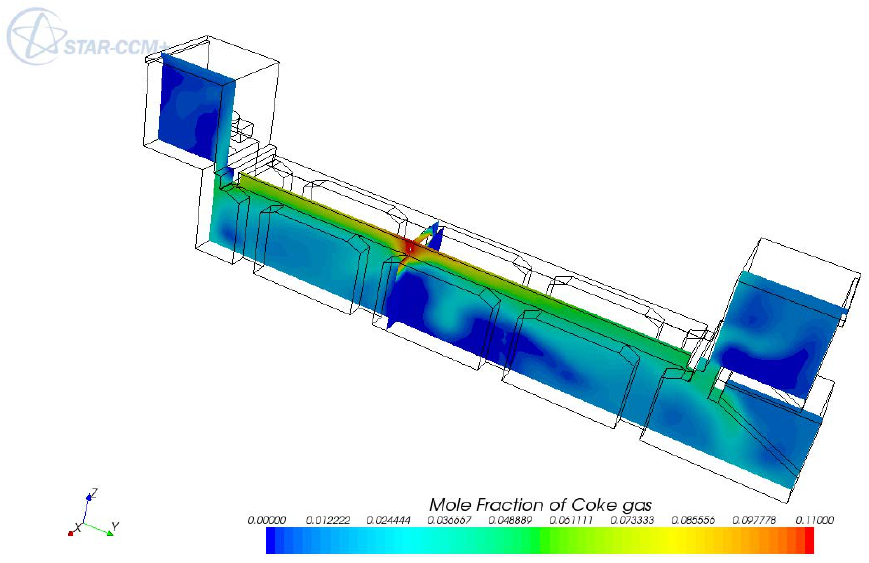
Figure 4. CFD model: mole fraction of coke gas at 600 s from the beginning of the release in the coke battery A.